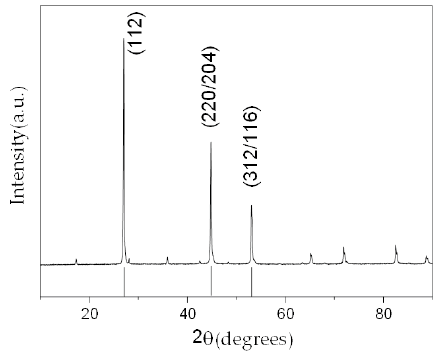
Figure 1. X-ray diffraction patterns of CuInGaSe 2 (CIGS) nanoparticles synthesized at 800 °C for 2 h.